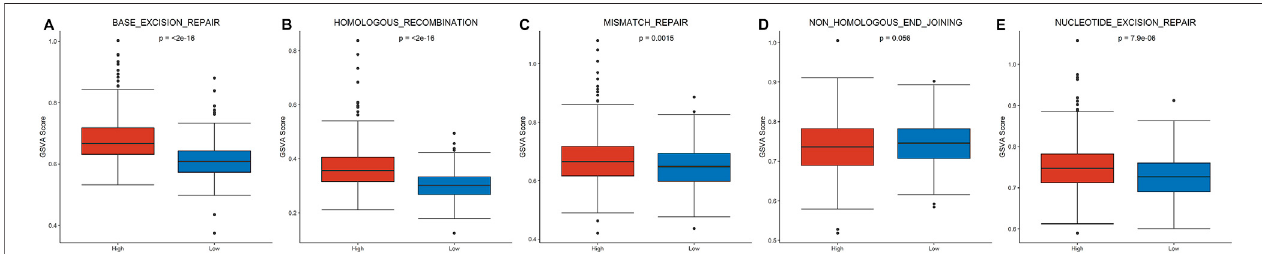
FIGURE 4 | Gene set enrichment analysis of DNA repair pathways between the high- and low-risk